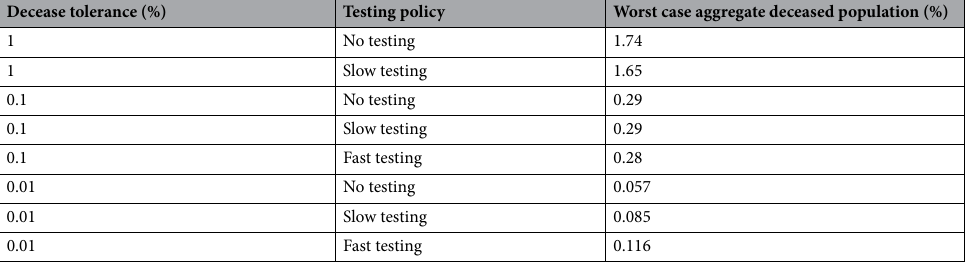
Table 1. Effect of uncertainty in the initial reproduction and infection fatality rates—Worst case aggregate deceased population. Worst case aggregate deceases for ¯ R 0 ∈ [ 3.17, 3.38 ] and infection fatality rate ranging between 0.39 and 1.33% when optimal continuous intervention strategies obtained with ¯ R 0 = 3.27 and infection fatality rate of 0.66% are implemented. The intervention strategies are associated with decease tolerances of 1% , 0.1% and 0.01% when no, slow and fast testing policies are respectively adopted. The worst case aggregate deceased population associated with each strategy is obtained when ¯ R 0 = 3.38 and the infection fatality rate is 1.33% , i.e. at the maximum values of the considered